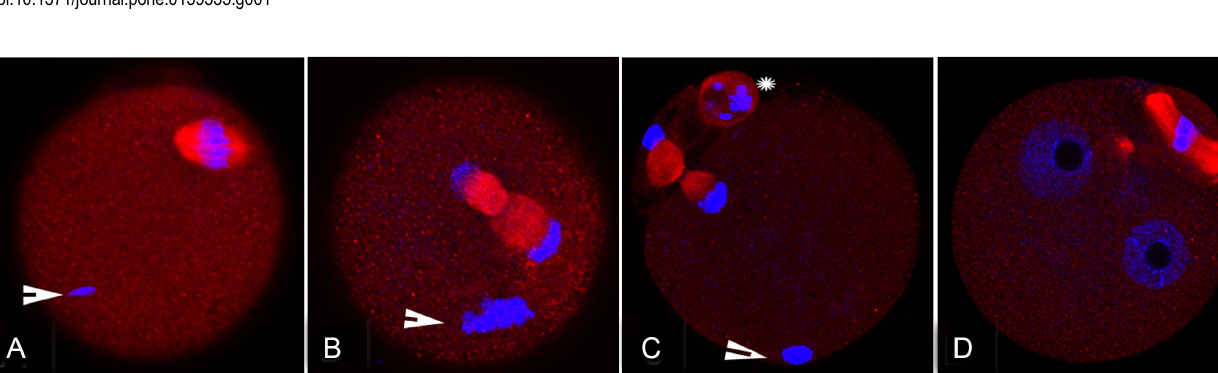
PLOS ONE | DOI:10.1371/journal.pone.0159535 July 27,